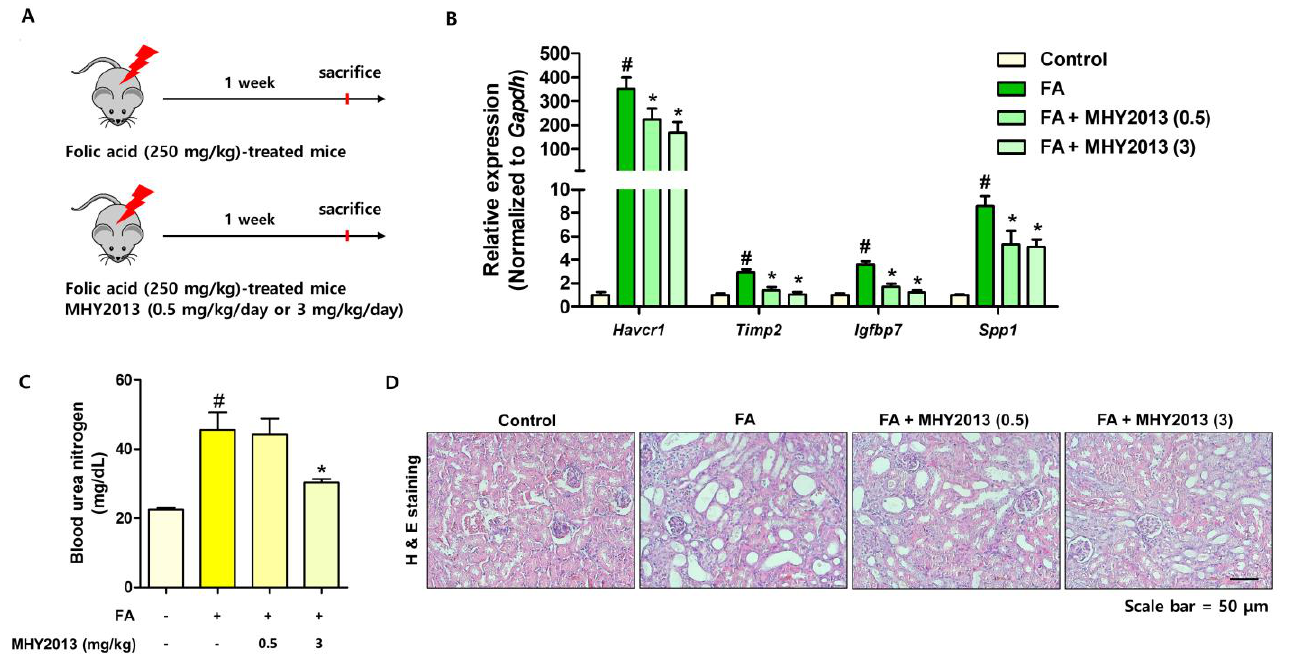
Figure 1. MHY2013 treatment reduces kidney damage induced with folic acid (FA) treatment. ( A ) Experimental scheme to evaluate the effect of MHY2013 using FA-induced mouse kidney fibrosis model ( n = 5~7). ( B ) Relative mRNA levels of kidney damage-related genes ( Havcr1 , Timp2 , Igfbp , and Spp1 ) in FA-treated kidneys with or without MHY2013 treatment. # p < 0.05 vs. control groups. * p < 0.05 vs. FA group. ( C ) Blood urea nitrogen (BUN) levels in FA-treated serums with or without MHY2013. # p < 0.05 vs. control groups. * p < 0.05 vs. FA group. ( D ) Representative images of H&E-stained sections of FA and/or MHY2013-treated kidneys.